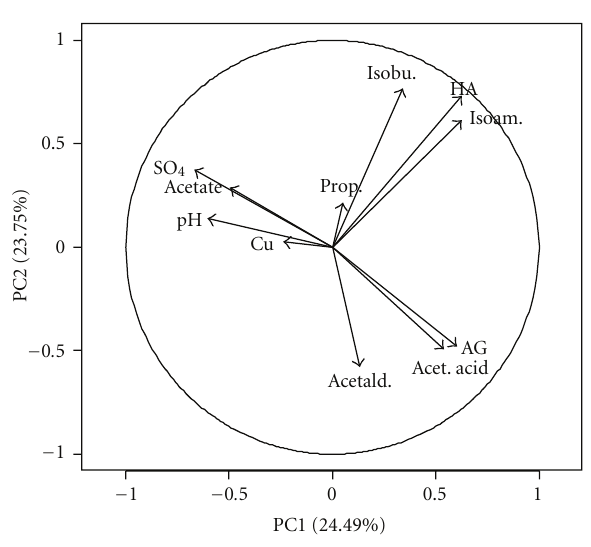
Figure 3: Loadings plot.